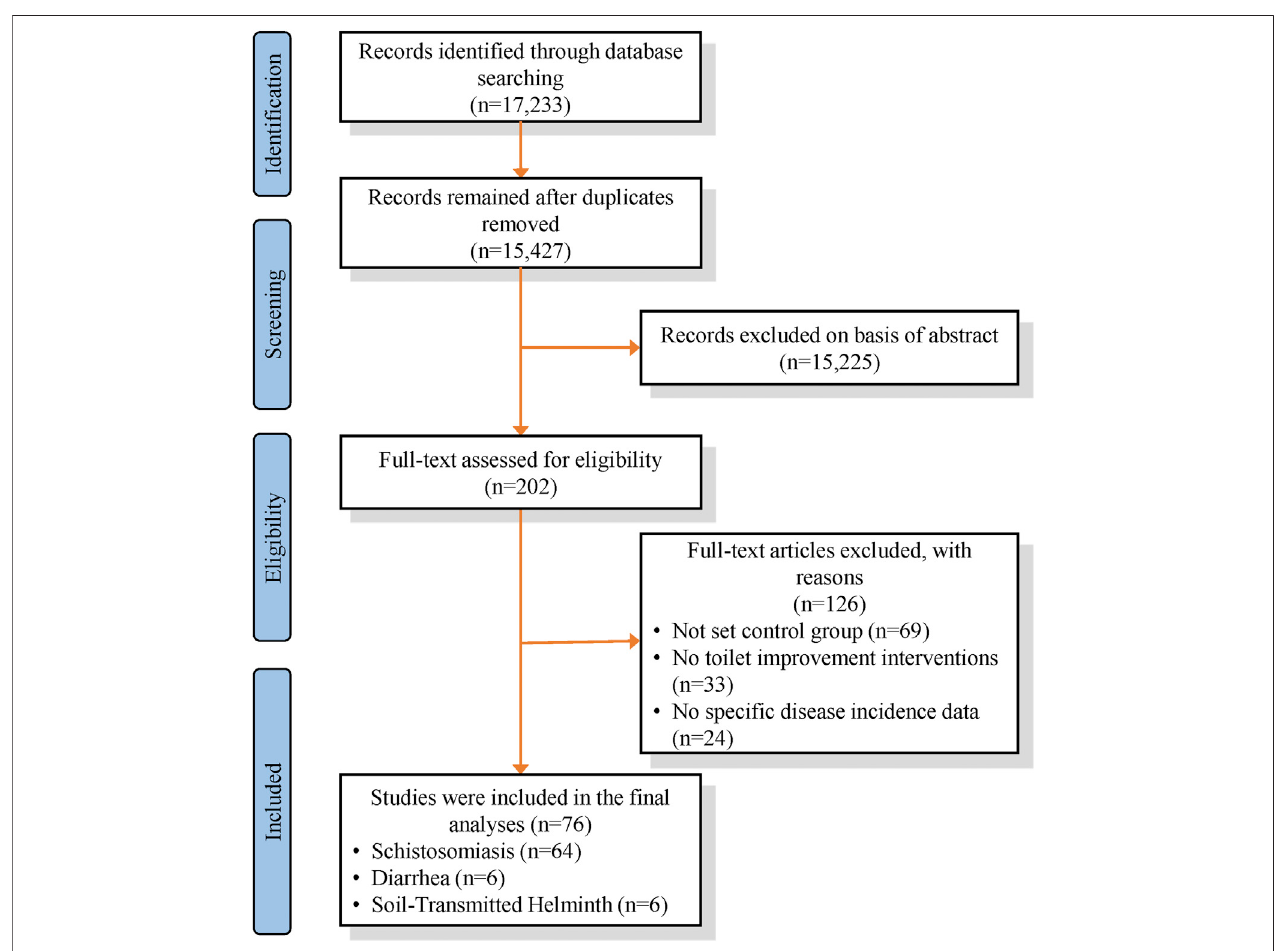
FIGURE 1 | Overview of the Preferred Reporting Items for Systematic Reviews and Meta-Analyses strategy used for the selection of articles.